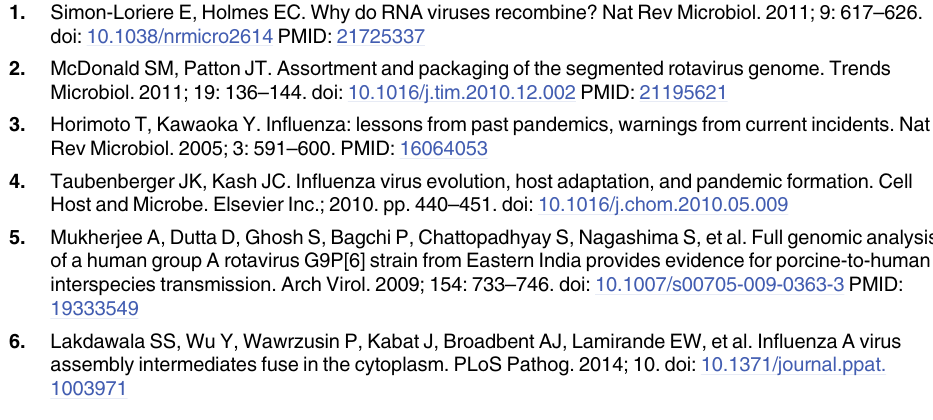
S2 Fig. Time-scaled Seg-2 phylogeny of European BTV-1(e) isolates. No evidence of reas- sortment within Europe was detected within this data set. Shown is the maximum clade credi- bility tree estimated in program BEAST with branch lengths scaled in years. Inferred reassortment events (based on changes in genetic cluster assignment for one or more segments, shown on the right) are depicted next to tree nodes. Question marks in the genetic cluster assignments represented cases where the assignment was ambiguous (see Methods for further details). (EPS) S3 Fig. Time-scaled Seg-2 phylogeny of European BTV-2(e) isolates. See S2 Fig for details. (EPS) S4 Fig. Time-scaled Seg-2 phylogeny of European BTV-8 isolates. See S2 Fig for details. (EPS) S5 Fig. Time-scaled Seg-2 phylogeny of European BTV-9(w) isolates. See S2 Fig for details. (EPS) S6 Fig. Time-scaled Seg-2 phylogeny of European BTV-9(e) isolates. See S2 Fig for details. (EPS) S1 Table. List of European BTV isolates included in this study and associated metadata, including accession numbers. (XLSX) S2 Table. Genome-wide evolutionary rate estimates for BTV.